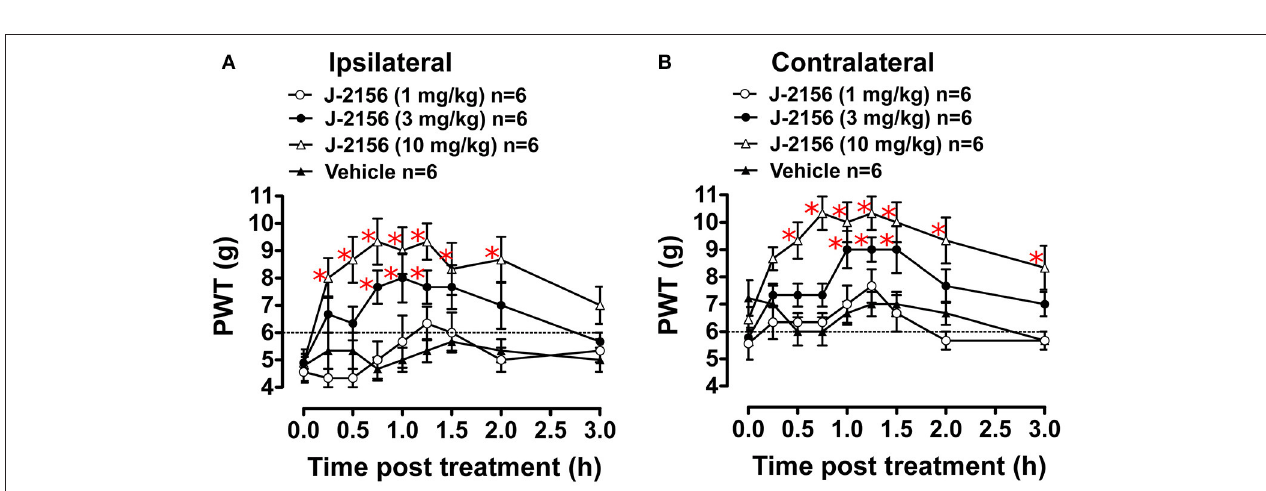
FIGURE 3 | Anti-allodynic effect of single bolus doses (i.p.) of J-2156 on ipsilateral and contralateral hindpaw withdrawal thresholds (PWTs) in BCIBP-rats. Panels in the figure show (A) ipsilateral PWT vs. time curves and (B) contralateral PWT vs. time curves. The dotted line shows the threshold criterion of fully developed mechanical allodynia ( ≤ 6g). Red asterisks * p ≤ 0.05 [ipsilateral: F (3,8,24 / 160) = 20.5, 6.4, 1.5; contralateral: F (3,8,24 / 160) = 21.6, 8.0, 1.8; Two-way ANOVA, post-hoc Bonferroni test c.f. BCIBP-rats administered vehicle]. Between-dose differences ( p ≤ 0.05) in the PWT values were also